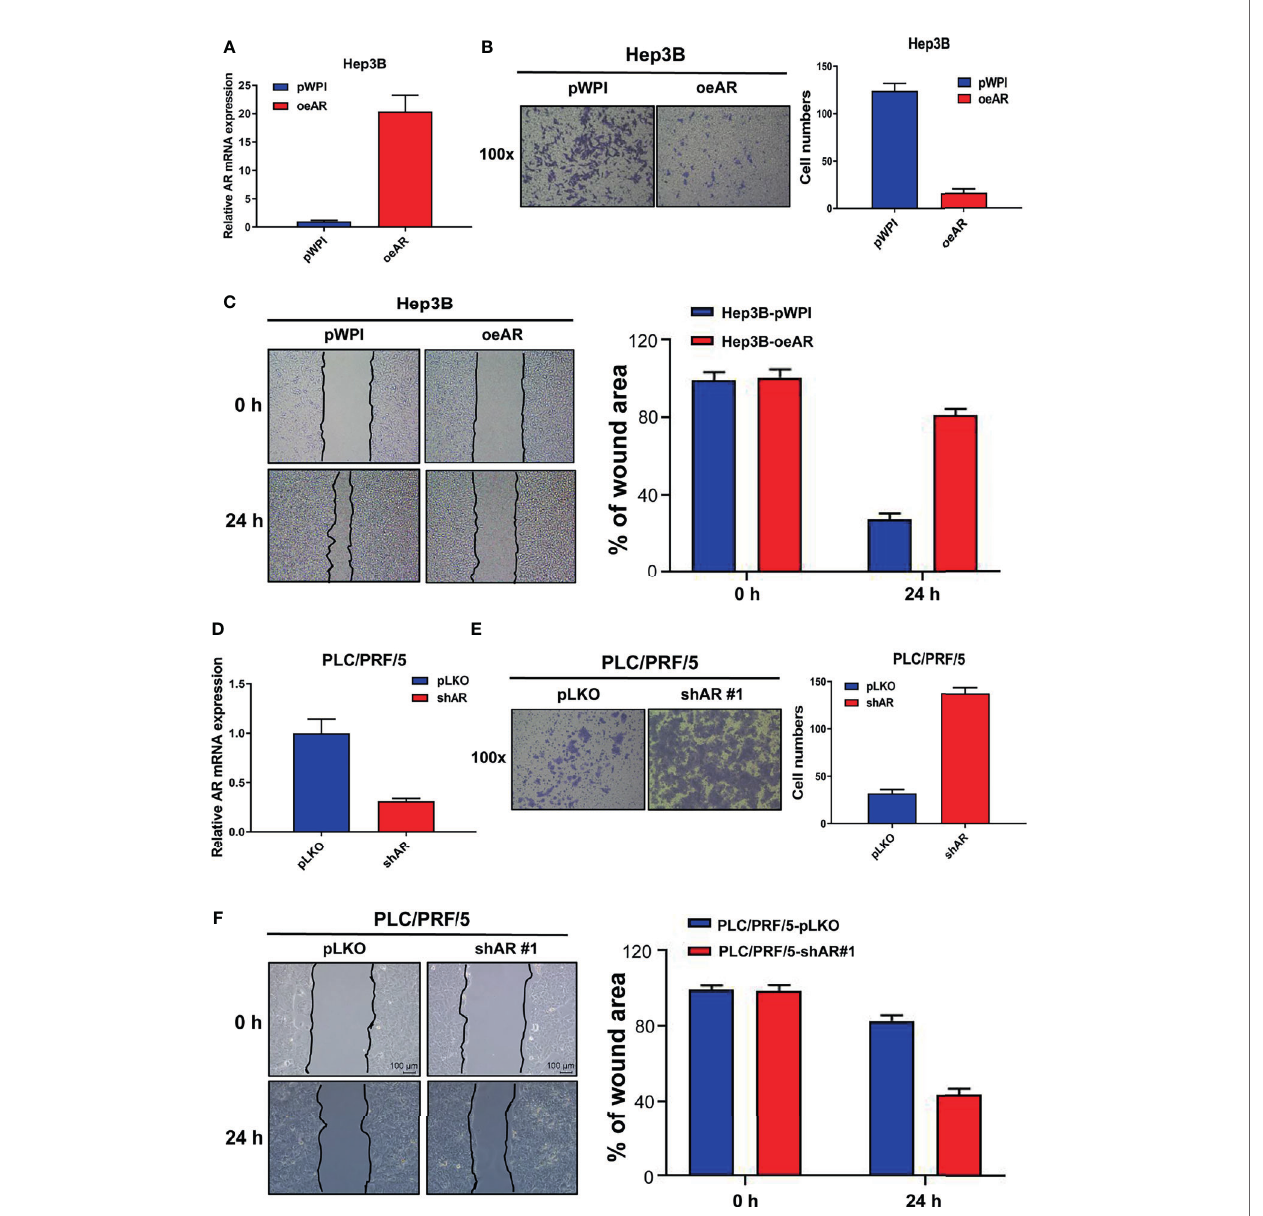
FIGURE 1 | AR could suppress HCC cells invasion and migration capacities. (A) qRT-PCR assay was used to check AR mRNA expression after overexpressing AR in HCC Hep3B cells. (B) Transwell invasion assay was used to check HCC Hep3B cells invasion capacity after oeAR in the cells. (C) Wound healing migration assay was used to check HCC Hep3B cells migration capacity after oeAR in the cells. (D) qRT-PCR assay was used to check AR mRNA expression after knocking down AR in HCC PLC/PRF/5 cells. (E) Transwell invasion assay was used to check HCC PLC/PRF/5 cells invasion capacity after shAR in the cells. (F) Wound healing migration assay was used to check HCC PLC/PRF/5 cells migration capacity after shAR in the